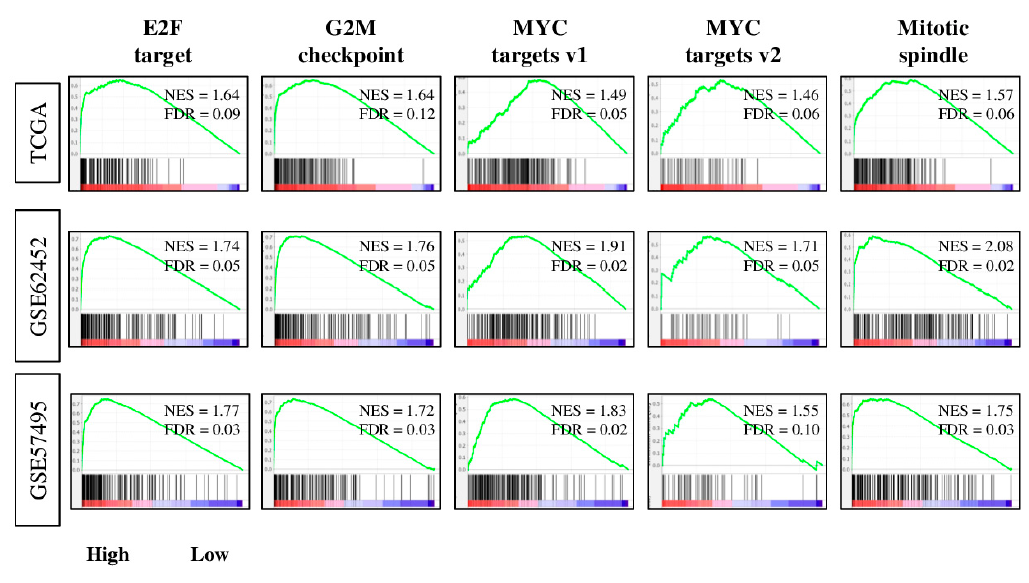
Figure 3. Gene set enrichment analysis (GSEA) of high-four-gene-score pancreatic cancer in the TCGA, GSE62452, and GSE57495 cohorts. Enrichment plots, along with normalized enrichment score (NES) and false discovery rate (FDR), are shown for cell proliferation-related Hallmark gene sets. The NES and FDR were determined with the classical GSEA method, where an FDR < 0.25 is considered significant.